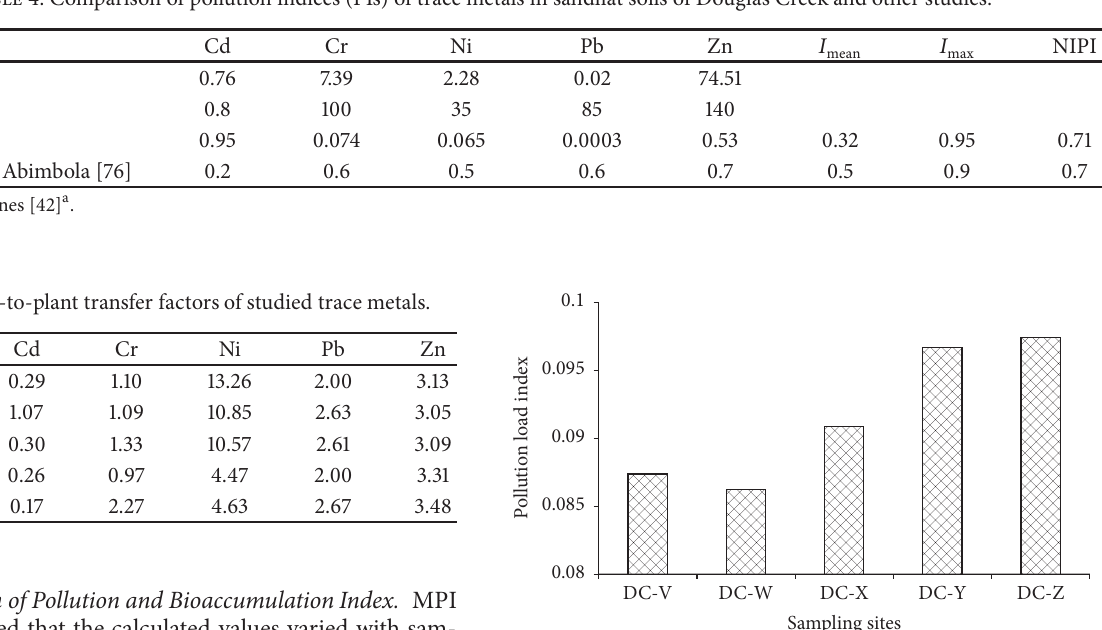
Table 4: Comparison of pollution indices (PIs) of trace metals in sandflat soils of Douglas Creek and other studies.